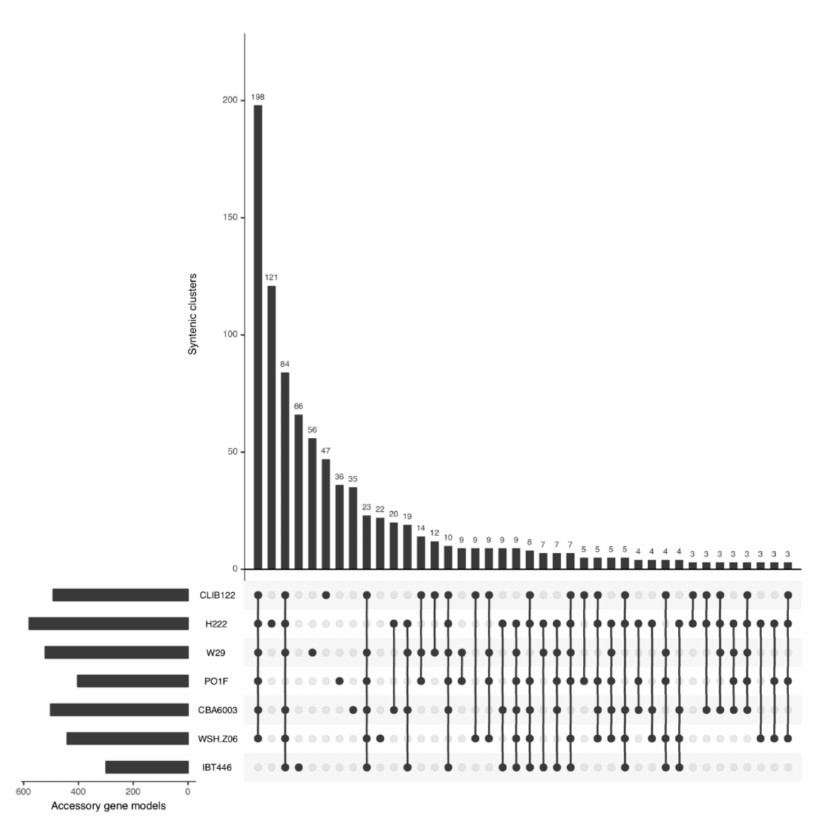
Figure 4. UpSet plot of the distribution of syntenic orthologs within the Yarrowia lipolytica accessory genome, ranked by syntenic cluster frequency. UpSet plots represent intersections between sets within data as a matrix and the number of occurrences of those intersections as a bar chart. In our case, the set intersection matrix represents clusters which contain a syntenic ortholog from 1–6 strains in our dataset and the number of their occurrences is given by the bar chart. Numbers of singleton clusters range from 22 in WSH-Z06 to 121 in H222. Figure generated by